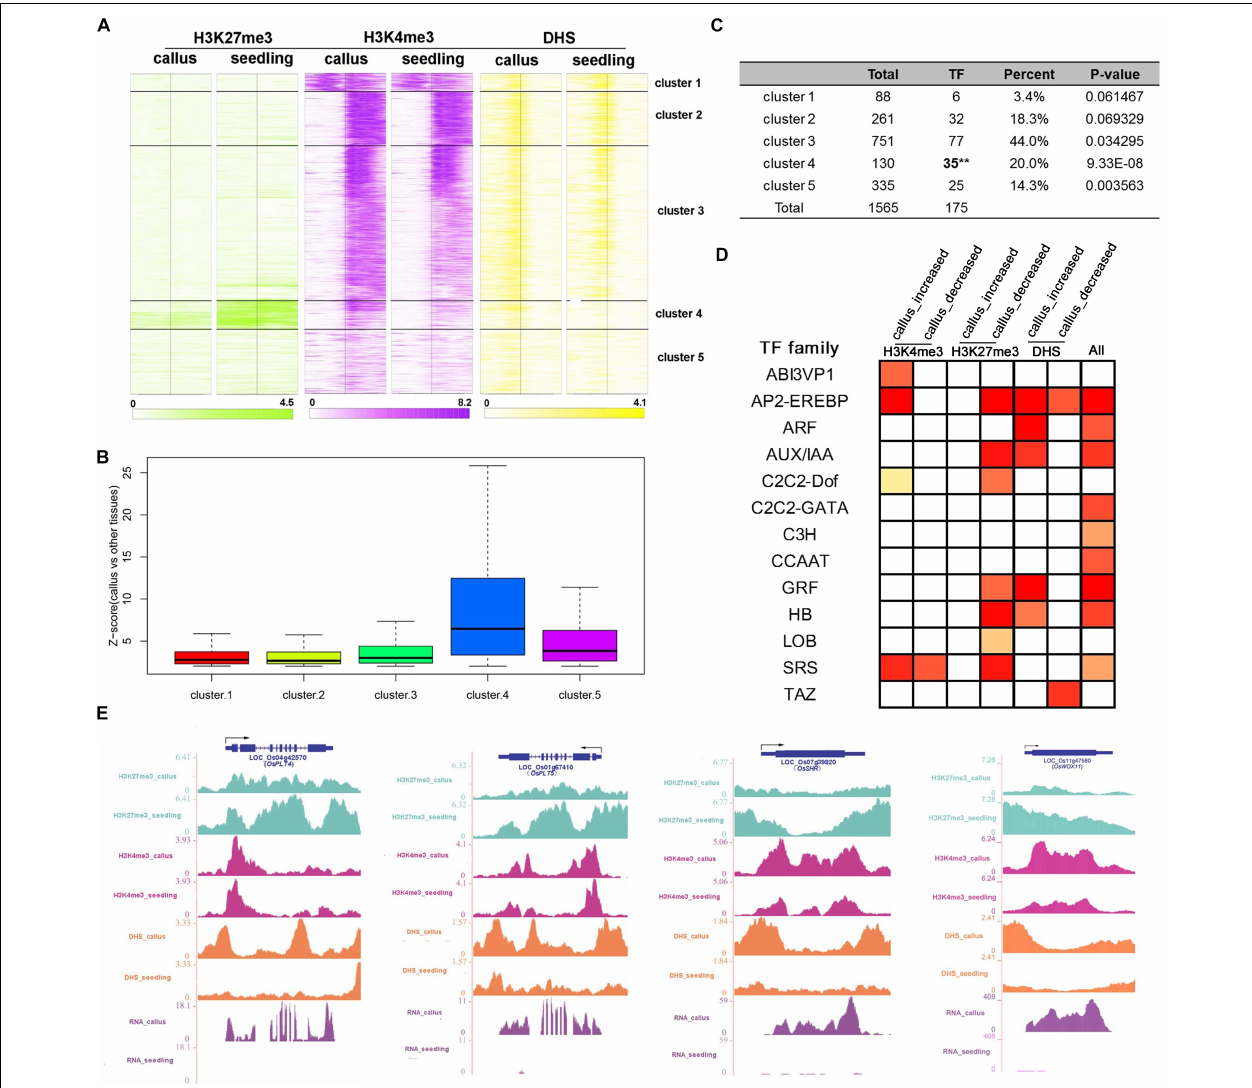
FIGURE 5 | Combination analysis of H3K27me3, H3K4me3, and DHSs near the callus-preferential genes. (A) Heatmap of H3K27me3, H3K4me3, and DHSs around the TSSs of 1,587 callus-preferential genes (from 1 kb upstream to 1 kb downstream regions of TSSs). All 1,587 genes were clustered on the basis of their enrichment, using the k -means method. (B) Z -scores (callus vs. other tissues) of 1,587 callus-preferential genes from five clusters in (A) . (C) TF enrichment analysis of five clusters using the hypergeometric distribution method. (D) TF family enrichment analysis of all 175 TFs preferentially expressed in the callus, and TFs with histone mark deposition, using the hypergeometric distribution method. (E) UCSC genome browser-based visualization for OsPLT4 , OsPLT5 , and OsSHR